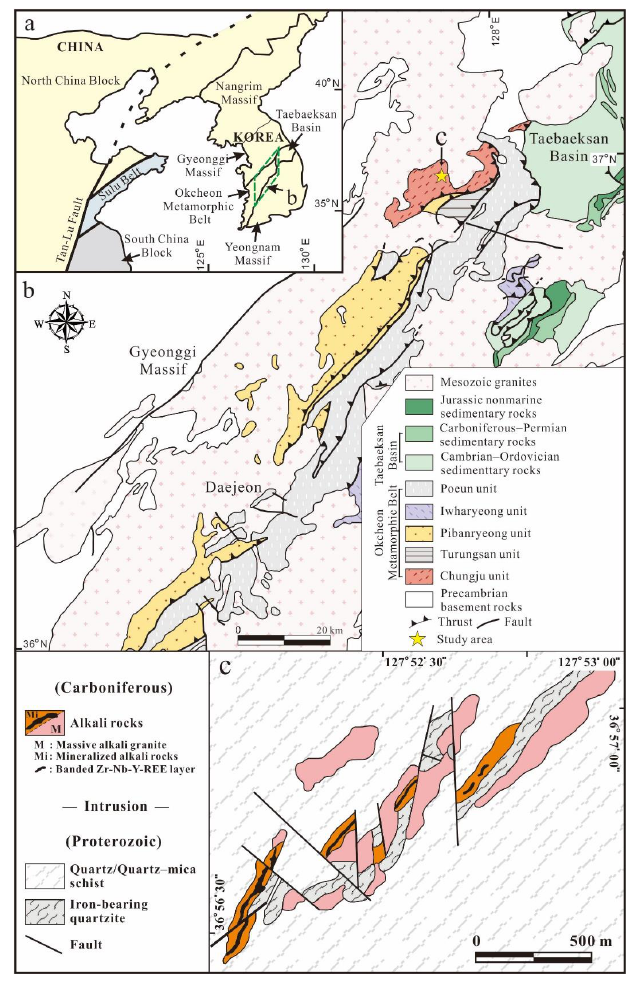
Figure 1. The location of the Chungju deposit and its geological setting. ( a ) A simplified map showing the tectonic provinces of East Asia, including the Korean Peninsula, modified from Reference [9]. ( b ) A geological map showing the stratigraphic/lithotectonic units of the Okcheon Metamorphic Belt and the Taebaeksan Basin, modified from Reference [9]. ( c ) A geological map of geological map showing the stratigraphic / lithotectonic units of the Okcheon Metamorphic Belt and the the studied area, modified from Reference [1]. Taebaeksan Basin, modified from Reference [9]. ( c ) A geological map of the studied area, modified from Reference